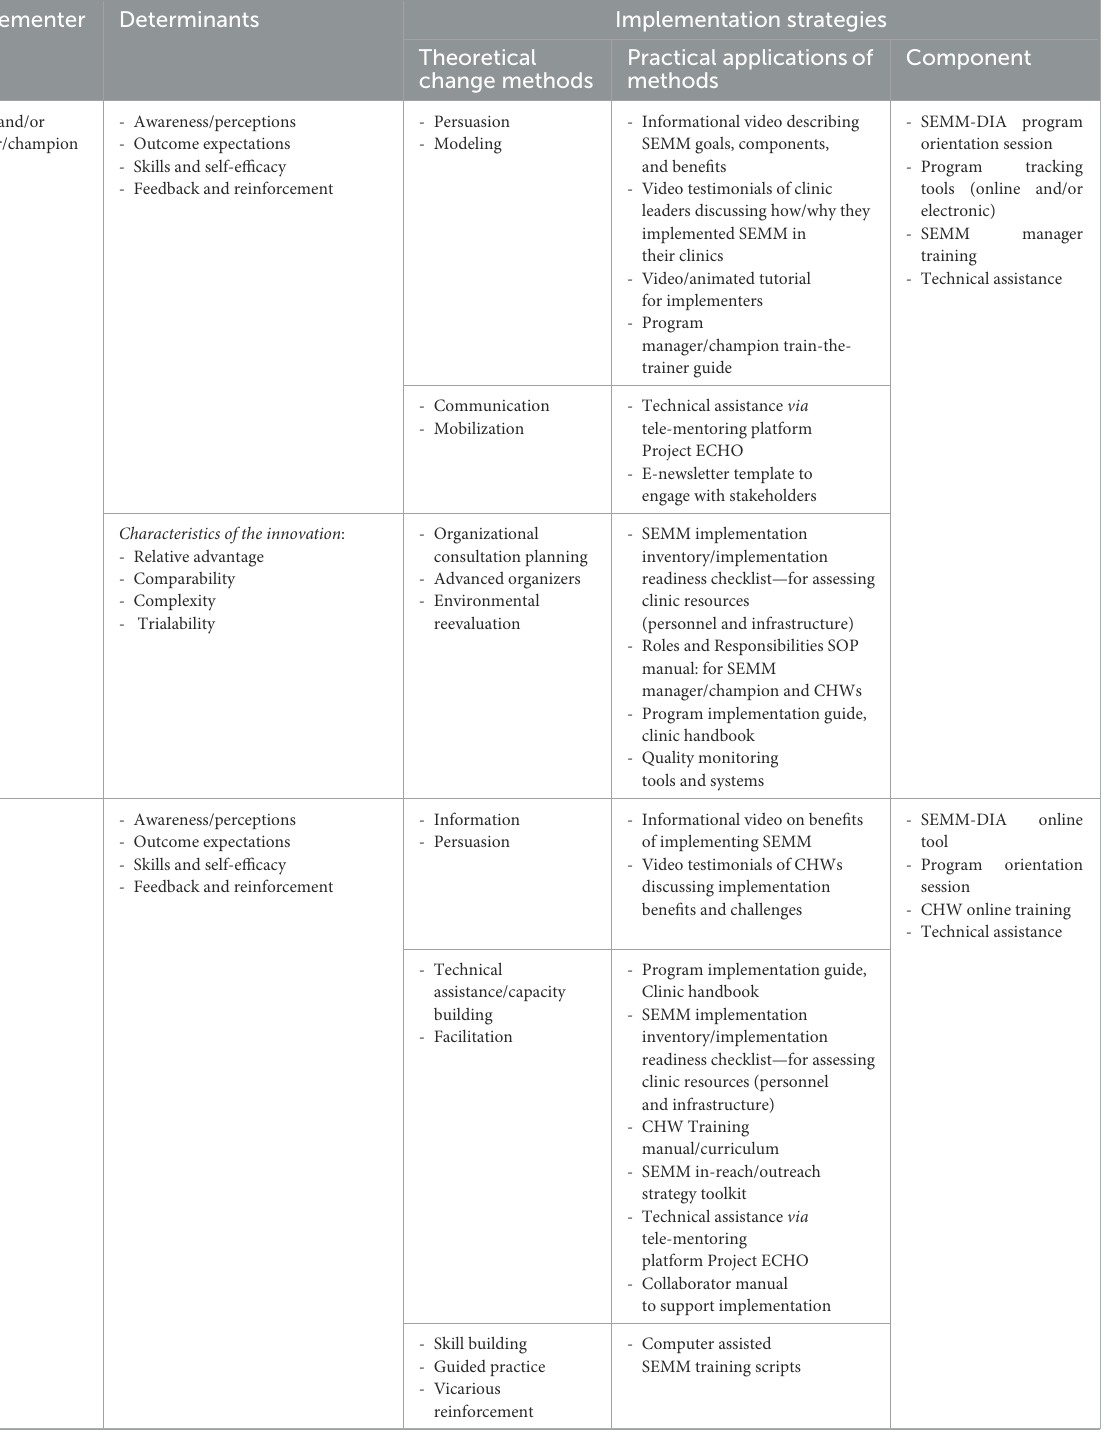
TABLE 5 SEMM-DIA program implementation intervention plan